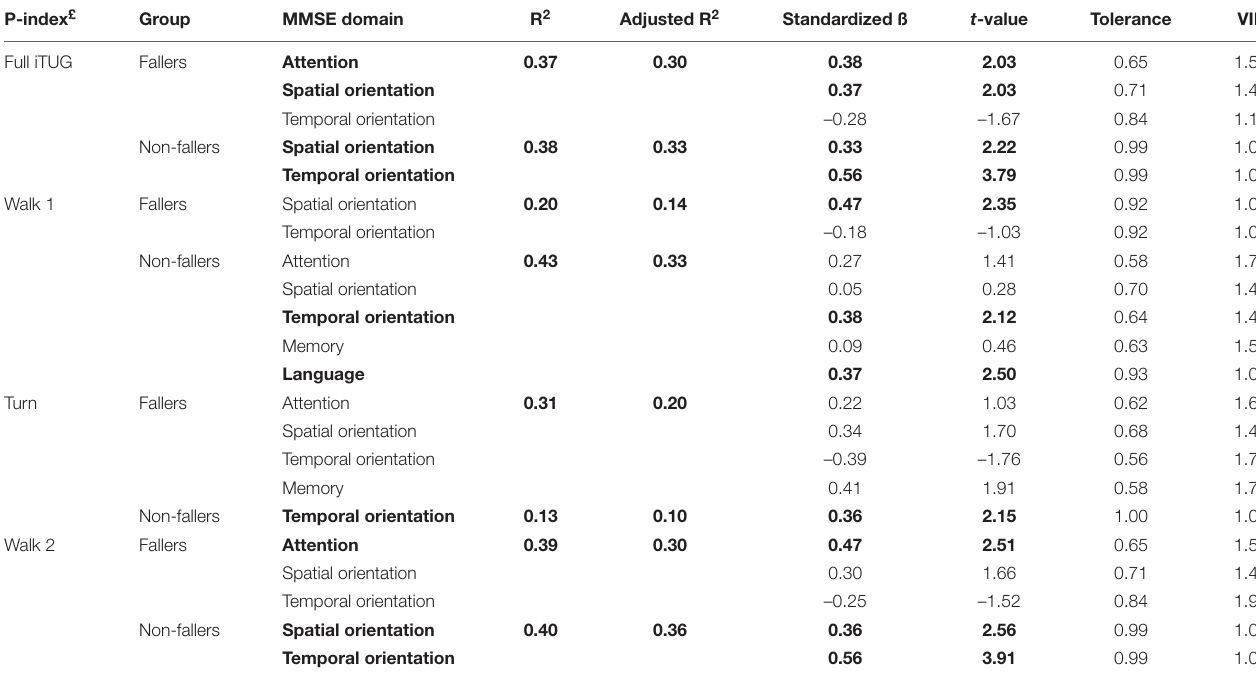
TABLE 3 | MMSE variation explained by the P-index using multiple linear